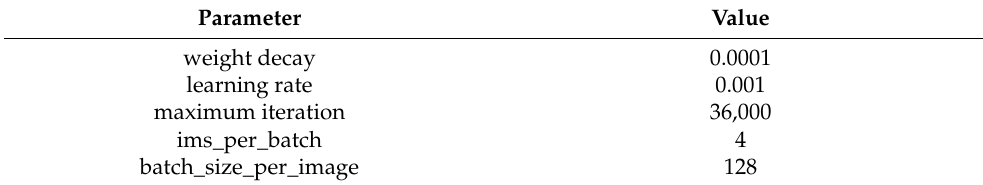
Table 2. Model training